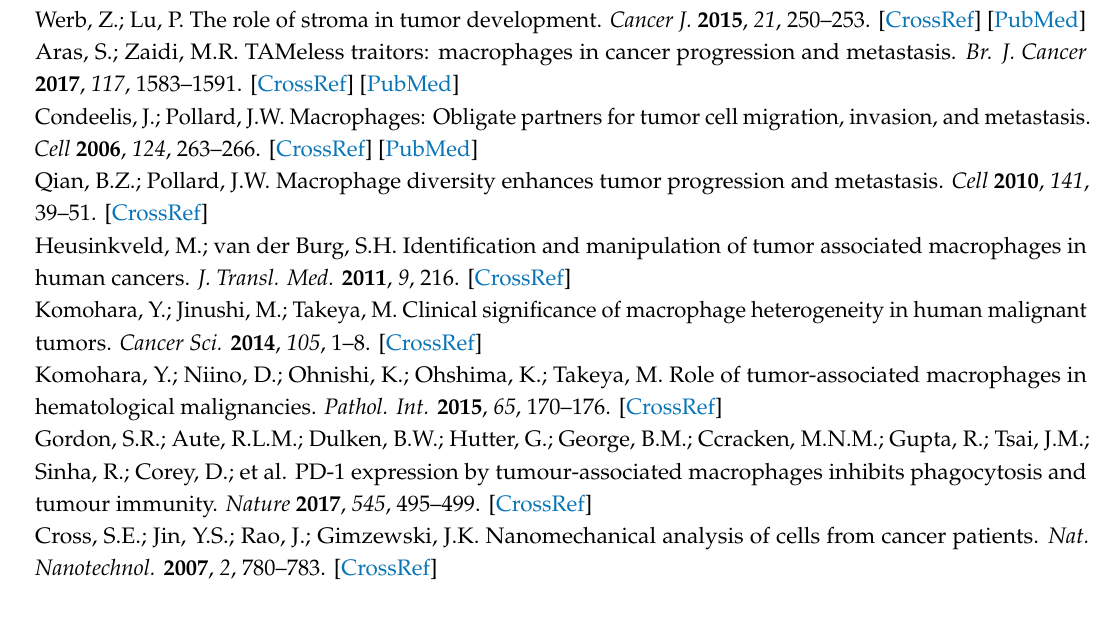
Figure S1: Immunofluorescence images of PD-1 expression on J774.2 (a) and MCF-7 (b, negative control) cells. Bright field (BF, left) and fluorescence (FL, right) images are shown. Bars: 50 µ m. (c) Comparison of fluorescence intensities between J774.2 and MCF-7 cells. N = 62 for J774.2 and N = 57 for MCF-7. Figure S2: Immunofluorescence images of E-cadherin (a), desmoglein (b), and claudin-4 (c) molecules on FP10SC2 (left) and MC-FP10SC2 (right) cells. Bars: 100 µ m. (d) Comparison of relative fluorescence intensities between FP10SC2 and MC-FP10SC2 cells for the three molecules. Values of FP10SC2 cells were used the standard for comparison. N = 38 and N = 43, N = 46 and N = 52, and N = 109 and N = 105 for FP10SC2 and MC-FP10SC2 cells for E-cadherin, desmoglein, and claudin-4, respectively. Figure S3: Fluorescence images of F-actin on FP10SC2 (left) and MC-FP10SC2 (right) cells. Bars, 100 µ